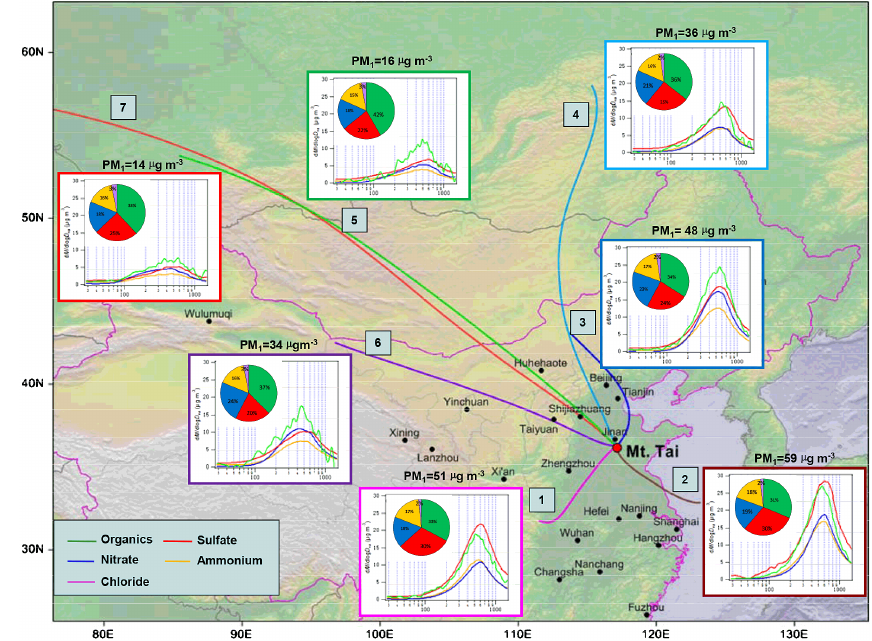
Figure 6. Averaged mass concentrations, mass-size distribution, and percentage of chemical components associated with different air-mass trajectory